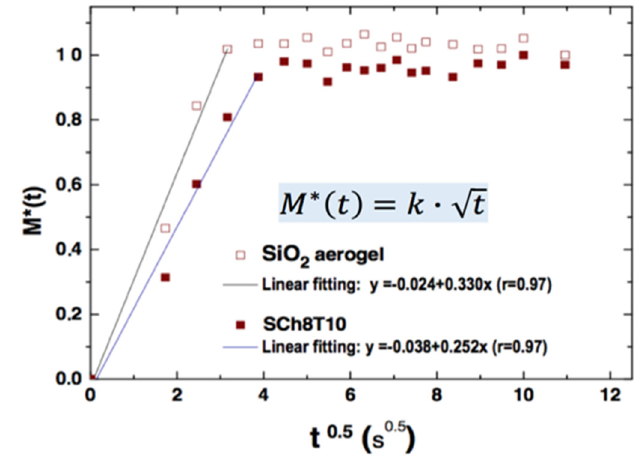
Figure 7. Water di ff usion process inside the aerogel with (closed red) and without (open red) CS. Figure 7. Water diffusion process inside the aerogel with (closed red) and without (open red) CS.